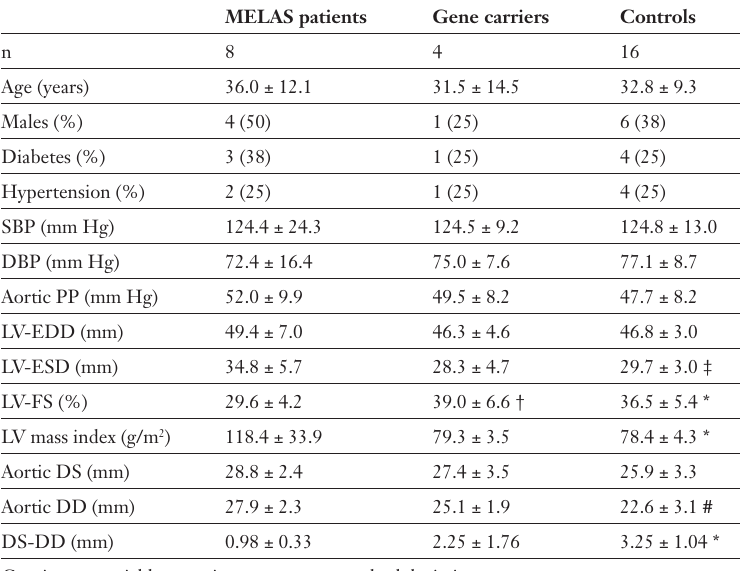
(SD) and diastolic (DD) di- ameters of the ascending aorta are shown on the M-mode tracing obtained 3 cm above the aortic